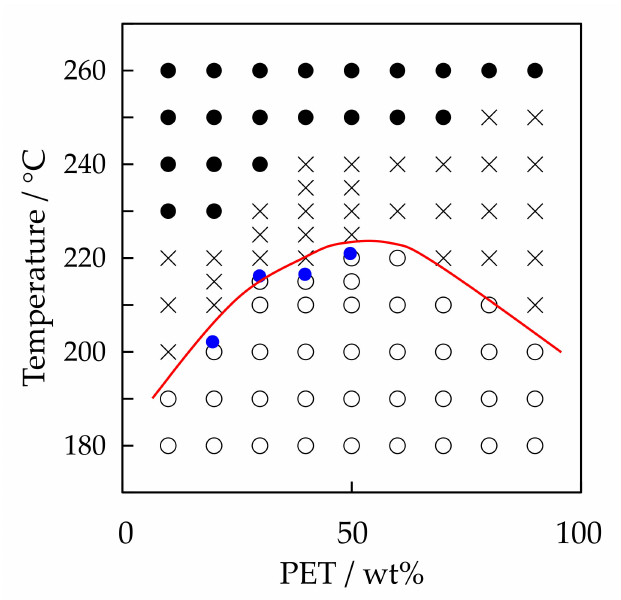
Figure 13. Phase diagram of the PTT / PET